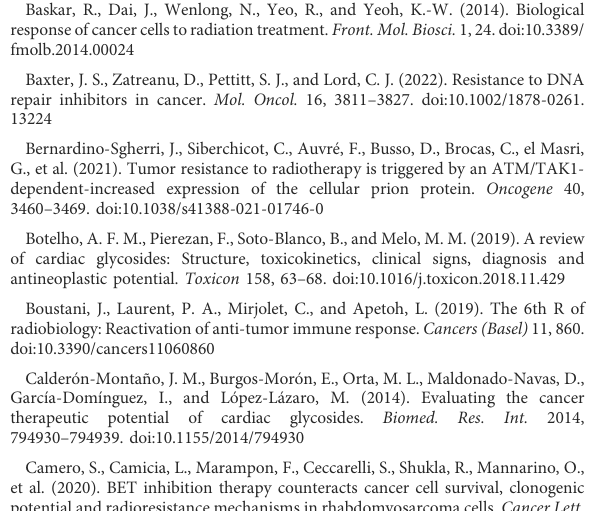
SUPPLEMENTAL FIGURE S1 Multipotent mesenchymal stromal cells (MSCs) are slightly sensitive to PBI-05204.DoseofPBI-05204abletoreduceby50%thecellsurvivalof MSCs cells. (B) Effect of PBI-05204 IC50 on cell number of dead MSCs cells. Surviving cells were counted using Trypan blue dye exclusion test. Results represent the mean values of three independent experiments ± SD.Statisticalsigni fi cance:*p ≤ 0.05,**p ≤ 0.01,***p ≤ 0.001,LiveCells, Untreated vs.